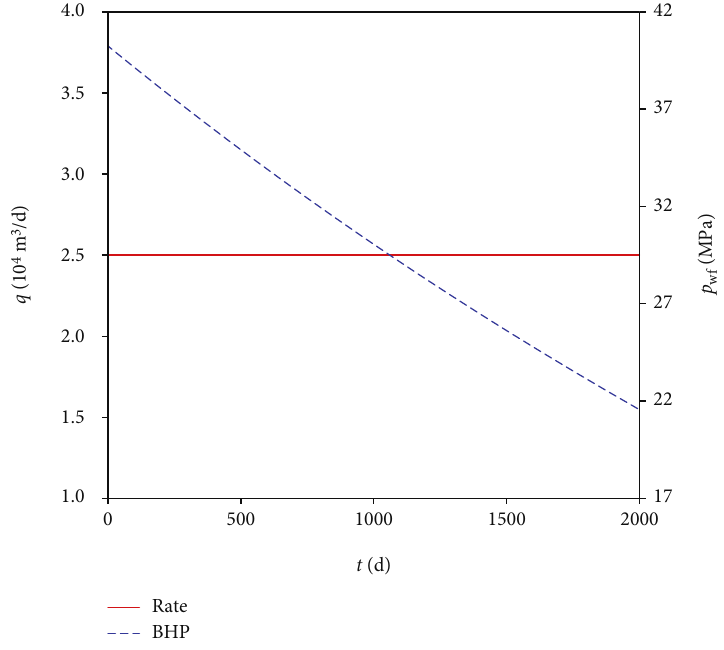
Figure 11: Production history of the gas well producing at a constant production